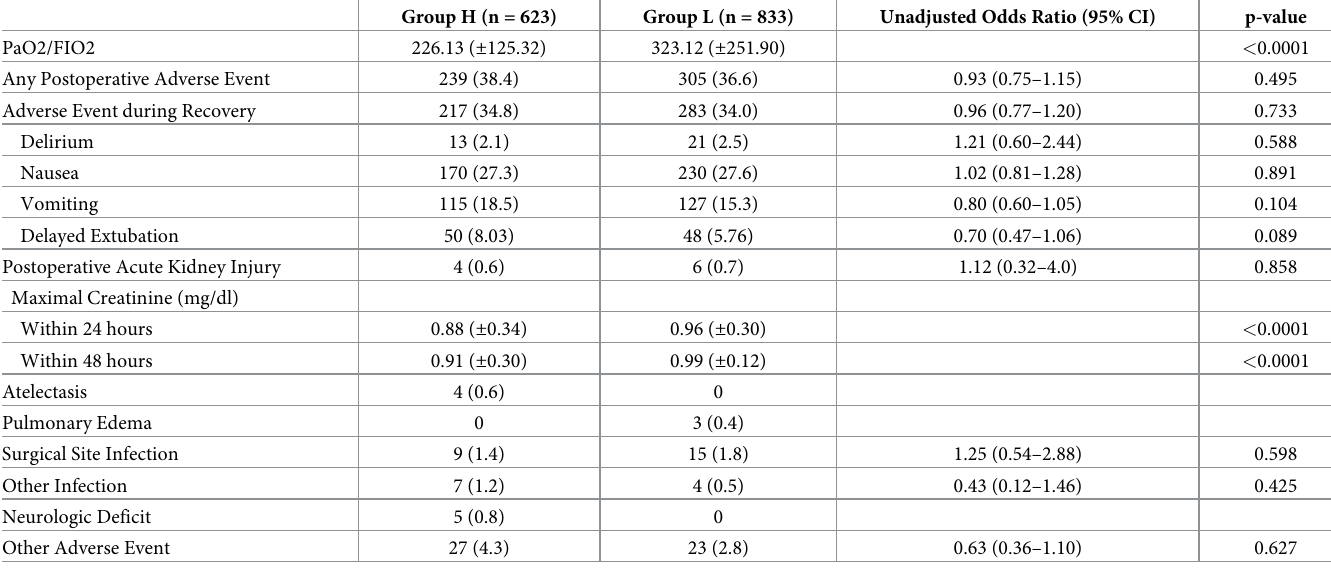
Table 2. Clinical outcomes of the entire